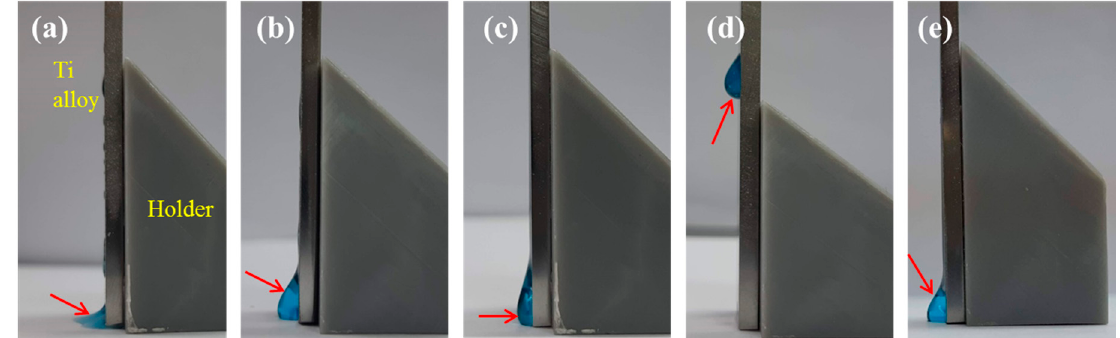
Figure 3. Images photographed for the retention efficacy of ( a ) methylene blue (MB)100, ( b ) quaternary ammonium chitosan (QTS)0.5 + MB100, ( c ) QTS1 + MB100, ( d ) QTS3 + MB100, and ( e ) MC1 + MB100 photosensitizers after the test solution was placed on the top of Ti alloy plate with 90-degree angle. Arrow indicates the flowing test solution.